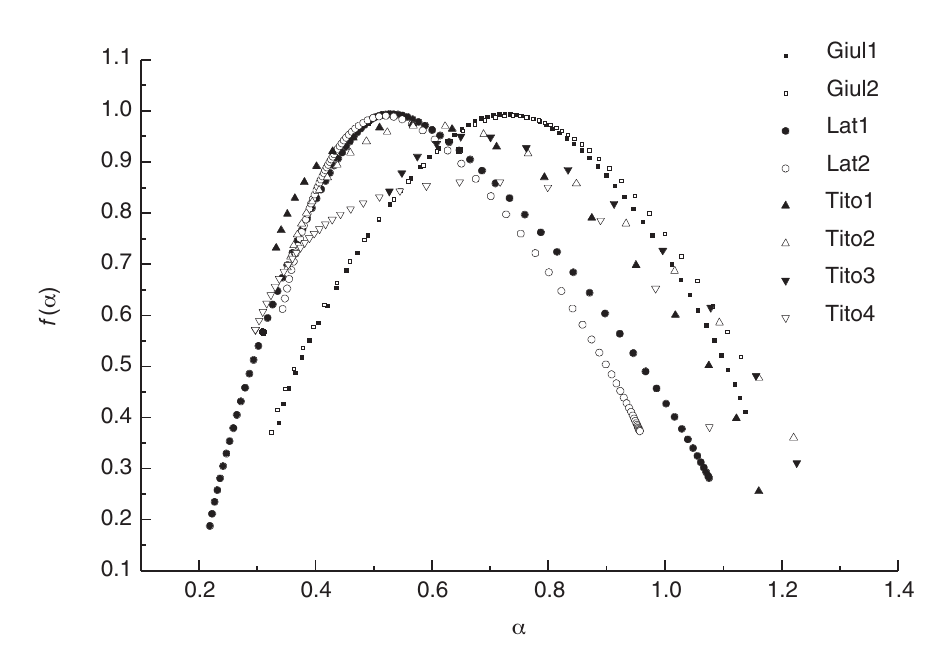
Fig. 4. Average Legendre spectra, calculated, for each signal, averaging the segment multifractal